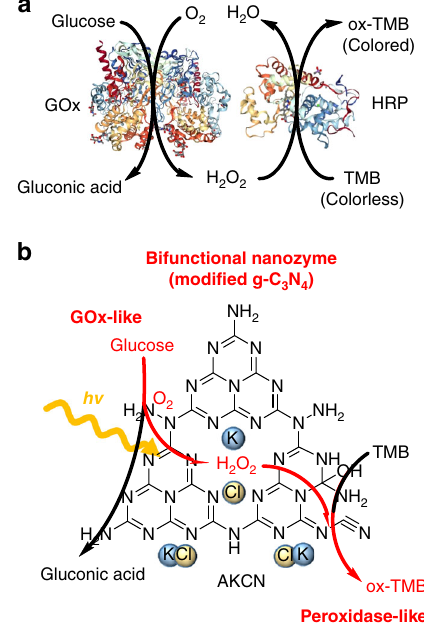
Fig. 1 Comparisons of glucose detection model in cascade reaction systems. a Glucose detection using enzymes: colorimetric detection of glucose using glucose oxidase (GOx) and horseradish peroxidase (HRP). b Glucose detection using a synthetic bifunctional nanozyme: photocatalytic aerobic oxidation of glucose with in situ production of H 2 O 2 on AKCN (modi fi ed GCN). In situ H 2 O 2 generated from glucose oxidation